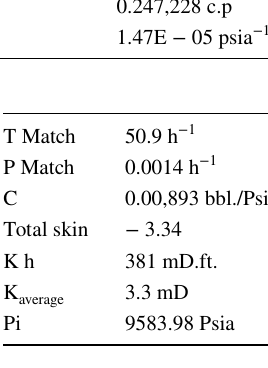
Table 6 Obtained data from buildup pressure test analysis after acidizing operation (PVT parameters) Oil Volume Factor